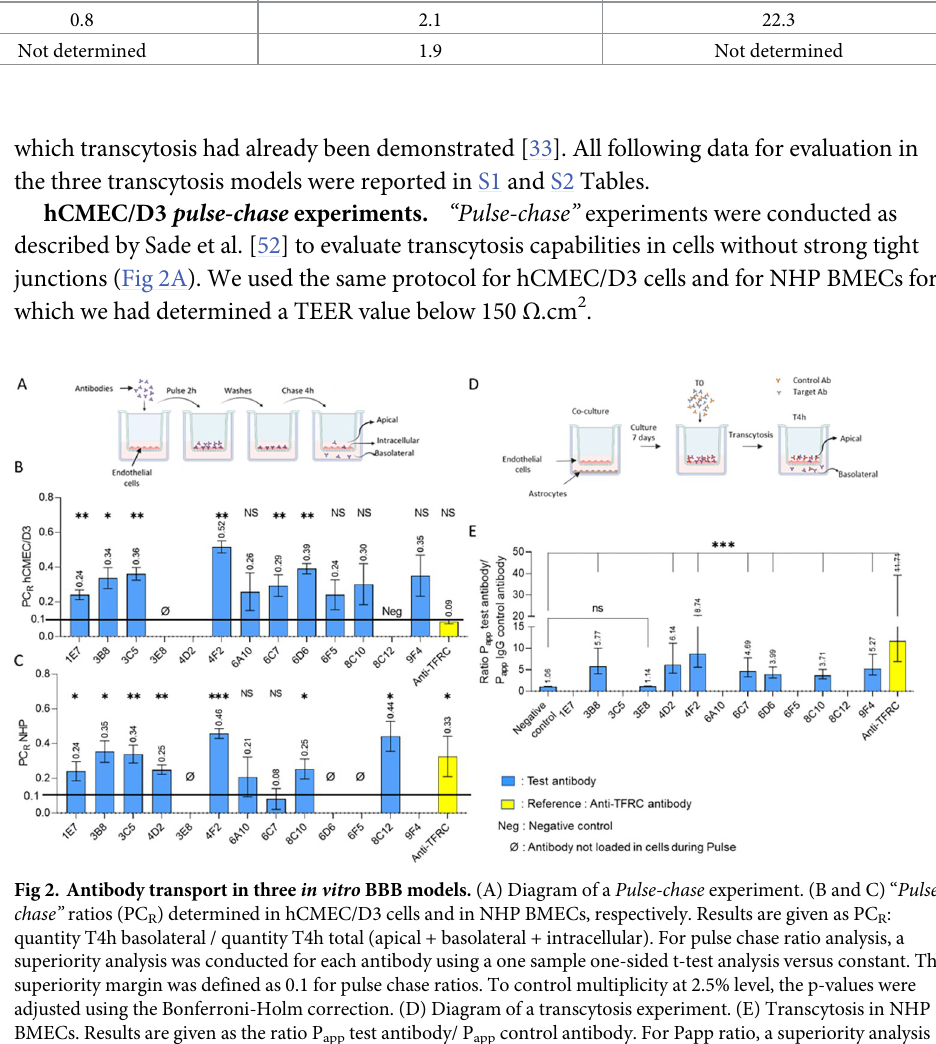
Fig 2. Antibody transport in three in vitro BBB models. (A) Diagram of a Pulse-chase experiment. (B and C) “ Pulse- chase” ratios (PC R ) determined in hCMEC/D3 cells and in NHP BMECs, respectively. Results are given as PC R : quantity T4h basolateral / quantity T4h total (apical + basolateral + intracellular). For pulse chase ratio analysis, a superiority analysis was conducted for each antibody using a one sample one-sided t-test analysis versus constant. The superiority margin was defined as 0.1 for pulse chase ratios. To control multiplicity at 2.5% level, the p-values were adjusted using the Bonferroni-Holm correction. (D) Diagram of a transcytosis experiment. (E) Transcytosis in NHP BMECs. Results are given as the ratio P app test antibody/ P app control antibody. For Papp ratio, a superiority analysis was conducted using an analysis of variance (ANOVA) to compare each antibody versus negative control followed by one-sided Dunnett’s test to control multiplicity at 2.5% level. Prior to statistical analysis, data were subjected to inverse transformation to ensure normality of residuals. (B, C, E) Blue bars represent test antibodies, yellow bar represents the reference anti-TFRC antibody. For each parameter, only antibodies with at least 3 measurements were included in statistical analysis. NS: p-value > 0,025, � : 0,01 < p-value < 0,025, �� : 0,001 < p-value < 0,01, ��� : p-value < 0,001 (A and D) images created by